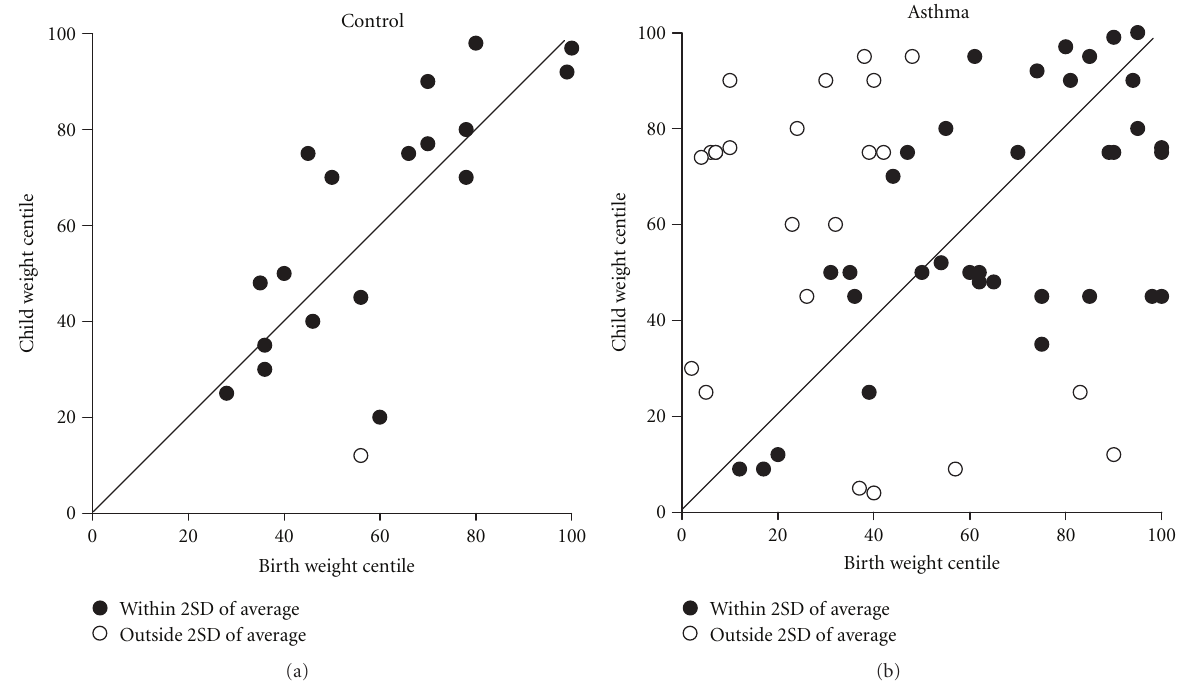
Figure 1: The association between birth weight centile and child weight centile (measured at 18 months) in children of healthy mothers (a) and mothers with asthma during pregnancy (b). Data points represent those children whose growth falls within two standard deviations (solid circles) of the mean growth trajectory, as indicated by the solid line, and those that fall outside of 2 standard deviations (open circles).